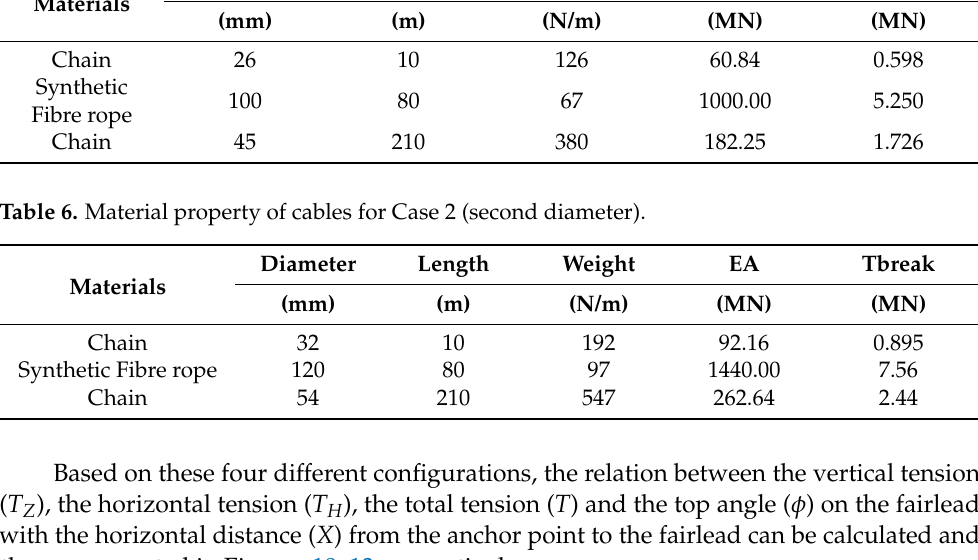
Table 5. Material property of cables for Case 2 (minimum diameter). Materials